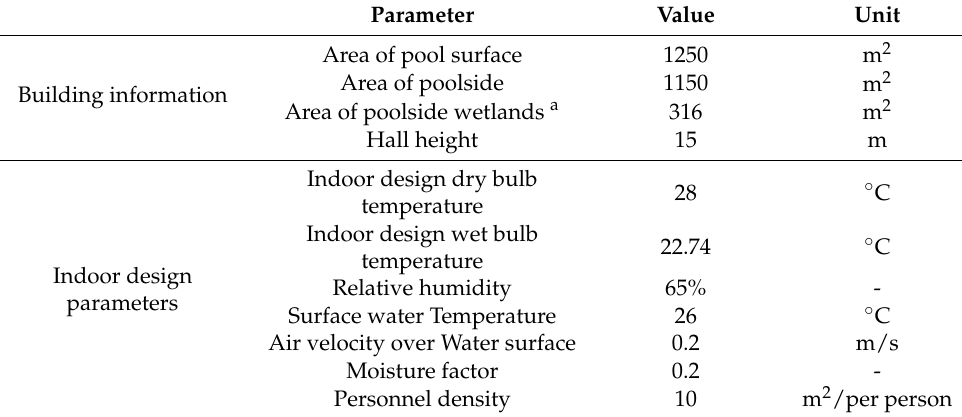
Table 7. Basic design parameters of natatorium.